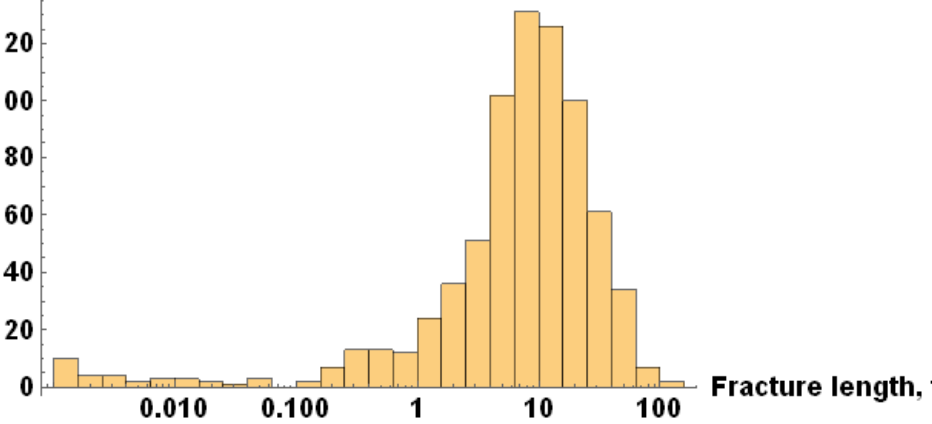
Figure 13—Histogram of the fracture length in Case